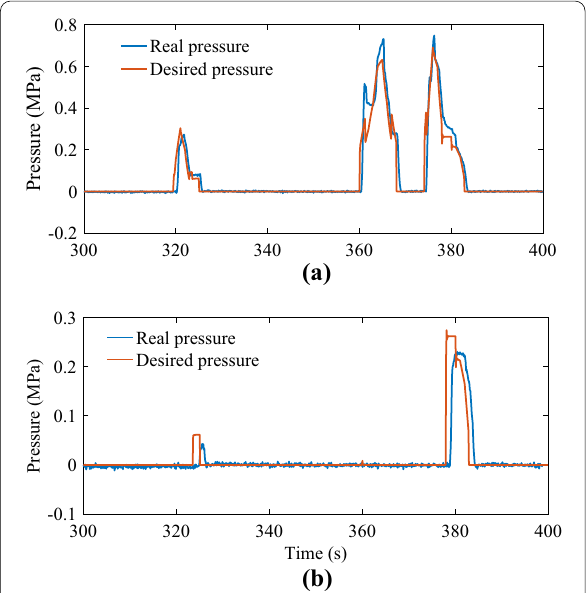
Figure 14 Braking chamber pressure: ( a ) front axle braking chamber pressure; ( b ) rear axle braking chamber pressure